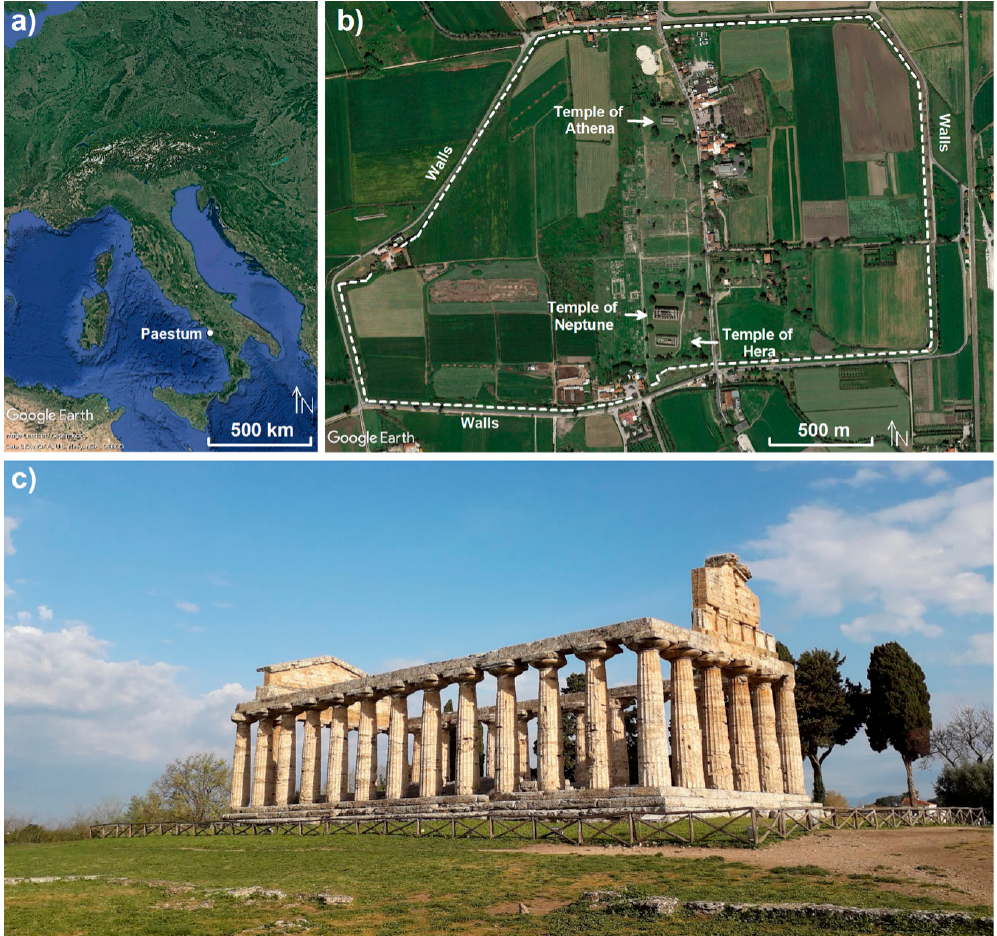
Figure 1. ( a ) Location of Greek–Roman Poseidonia-Paestum; ( b ) location of the Temple of Athena within the perimeter of the city walls; ( c ) view of the Temple of Athena from the southwest.